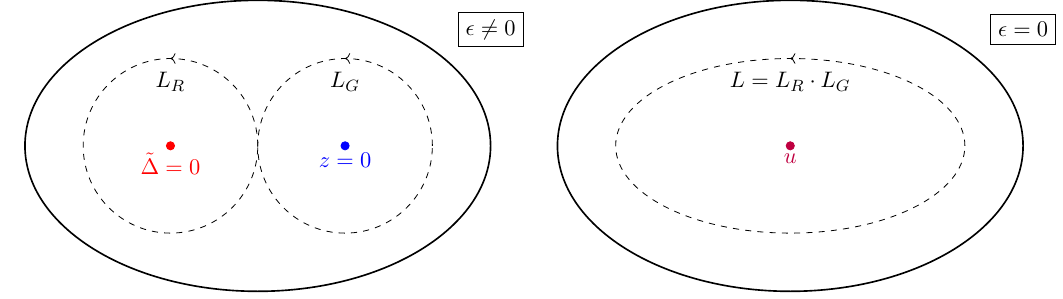
˜∆ = 0 the D 3 probe can either traverse the loop L = L R ◦ L G . L and L are as directed by the arrows. This disc can be deformed ◦ L − 1 G R G R